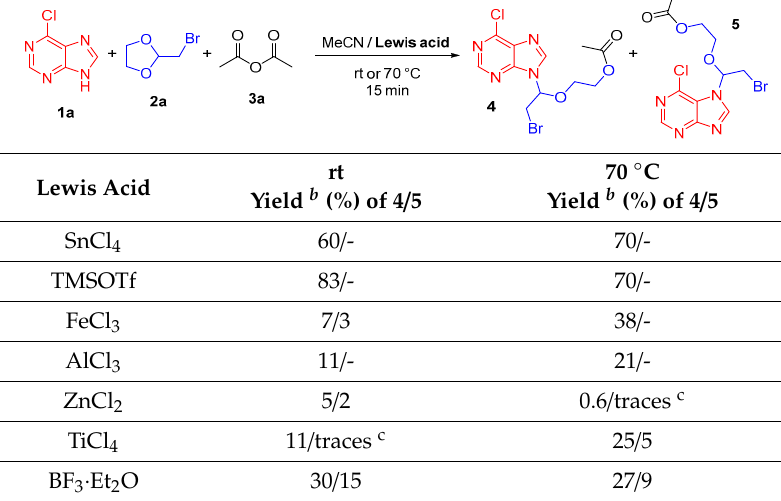
Molecules 2020 , 25 , x 4 of 22